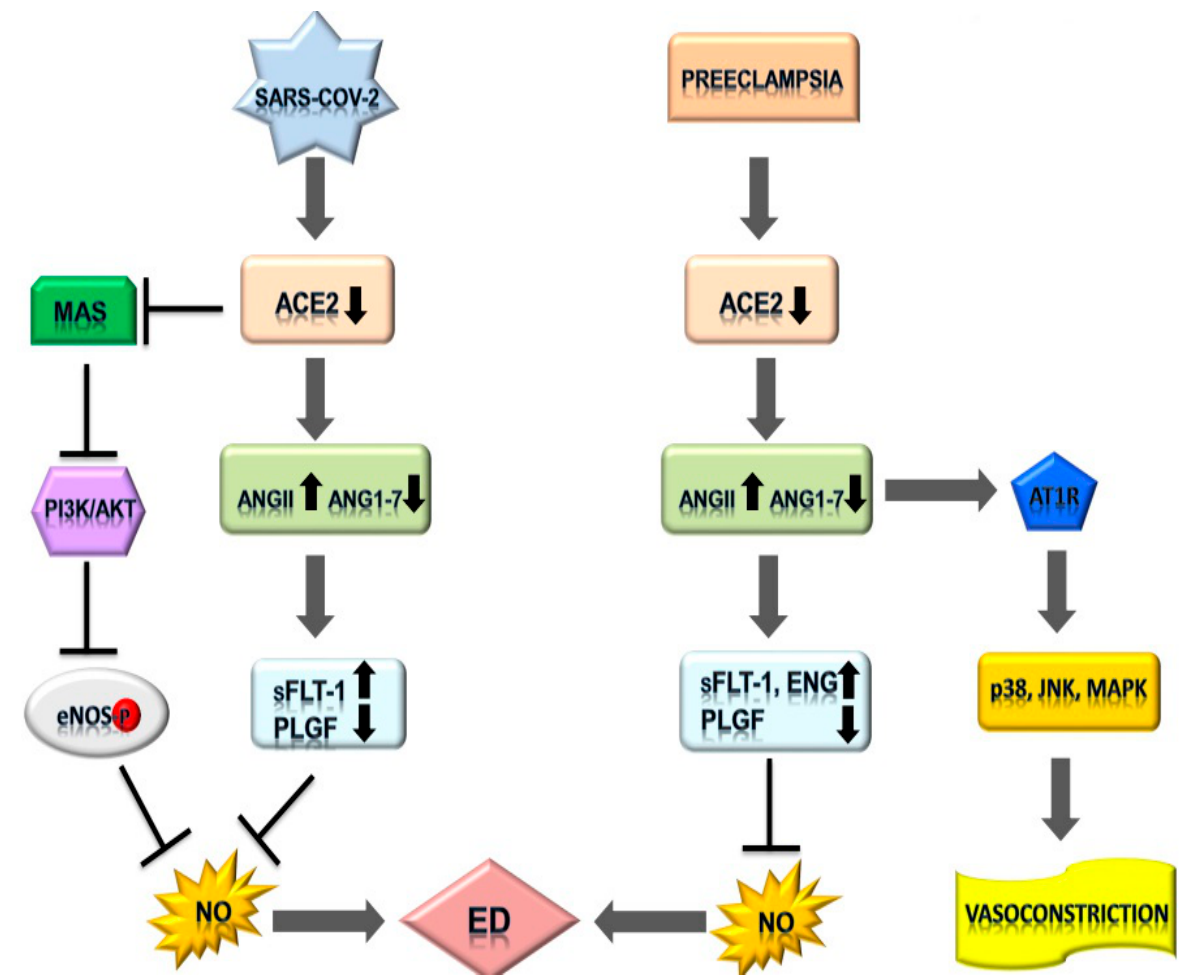
Figure 1. Comparison of activated RAS pathway leading to endothelial dysfunction (ED) during SARS-CoV-2 infection (left) and Preeclampsia (right) .